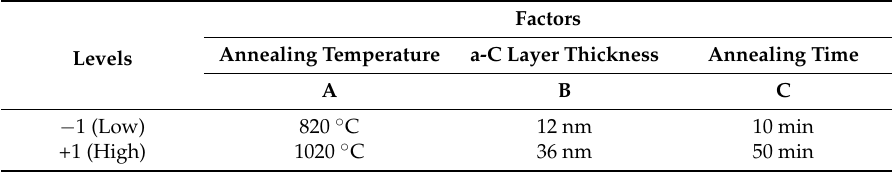
Table 1. Design-of-Experiments (DoE) factors. a-C, amorphous